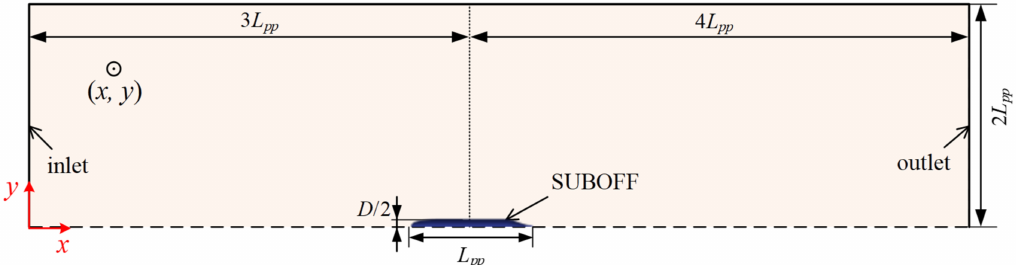
Figure 1. Computational domain.